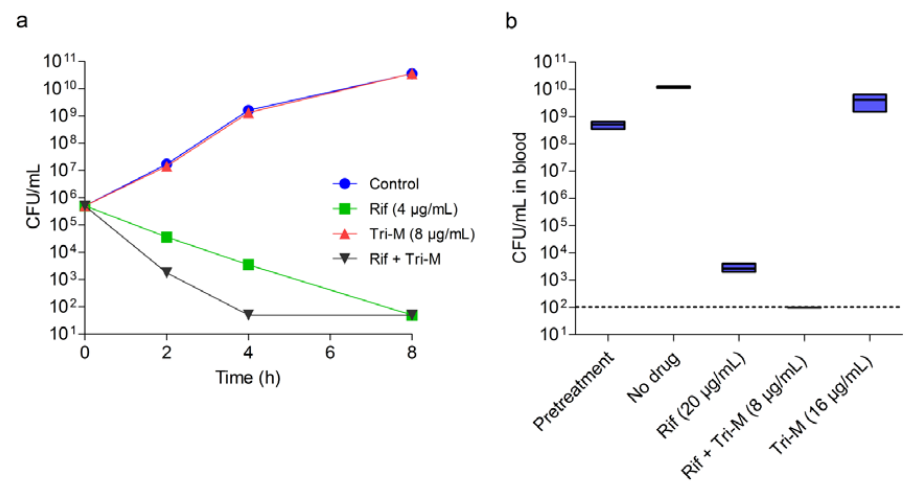
Figure 4. In vitro efficacy of tridecaptin M and rifampicin combination against A. baumannii ATCC 19606. ( a ) Killing of bacteria in nutrient-rich medium in the presence of antibiotics alone or in combination. The data are plotted as the mean of three replicates. Bars indicate the standard deviation. The experiment is representative of two biological repeats. ( b ) Killing of bacteria in rabbit blood after 4 h treatment. The data represent mean values of three replicates with standard deviation. The dotted line represents the limit of detection.